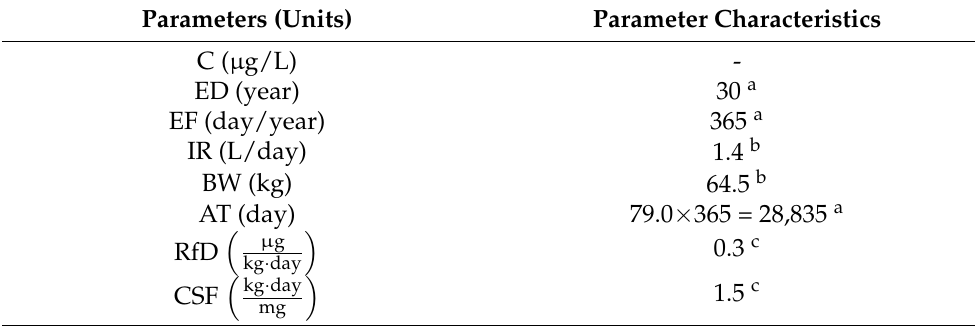
Table 7. Parameters used in calculating carcinogenic and noncarcinogenic health risk. Parameters